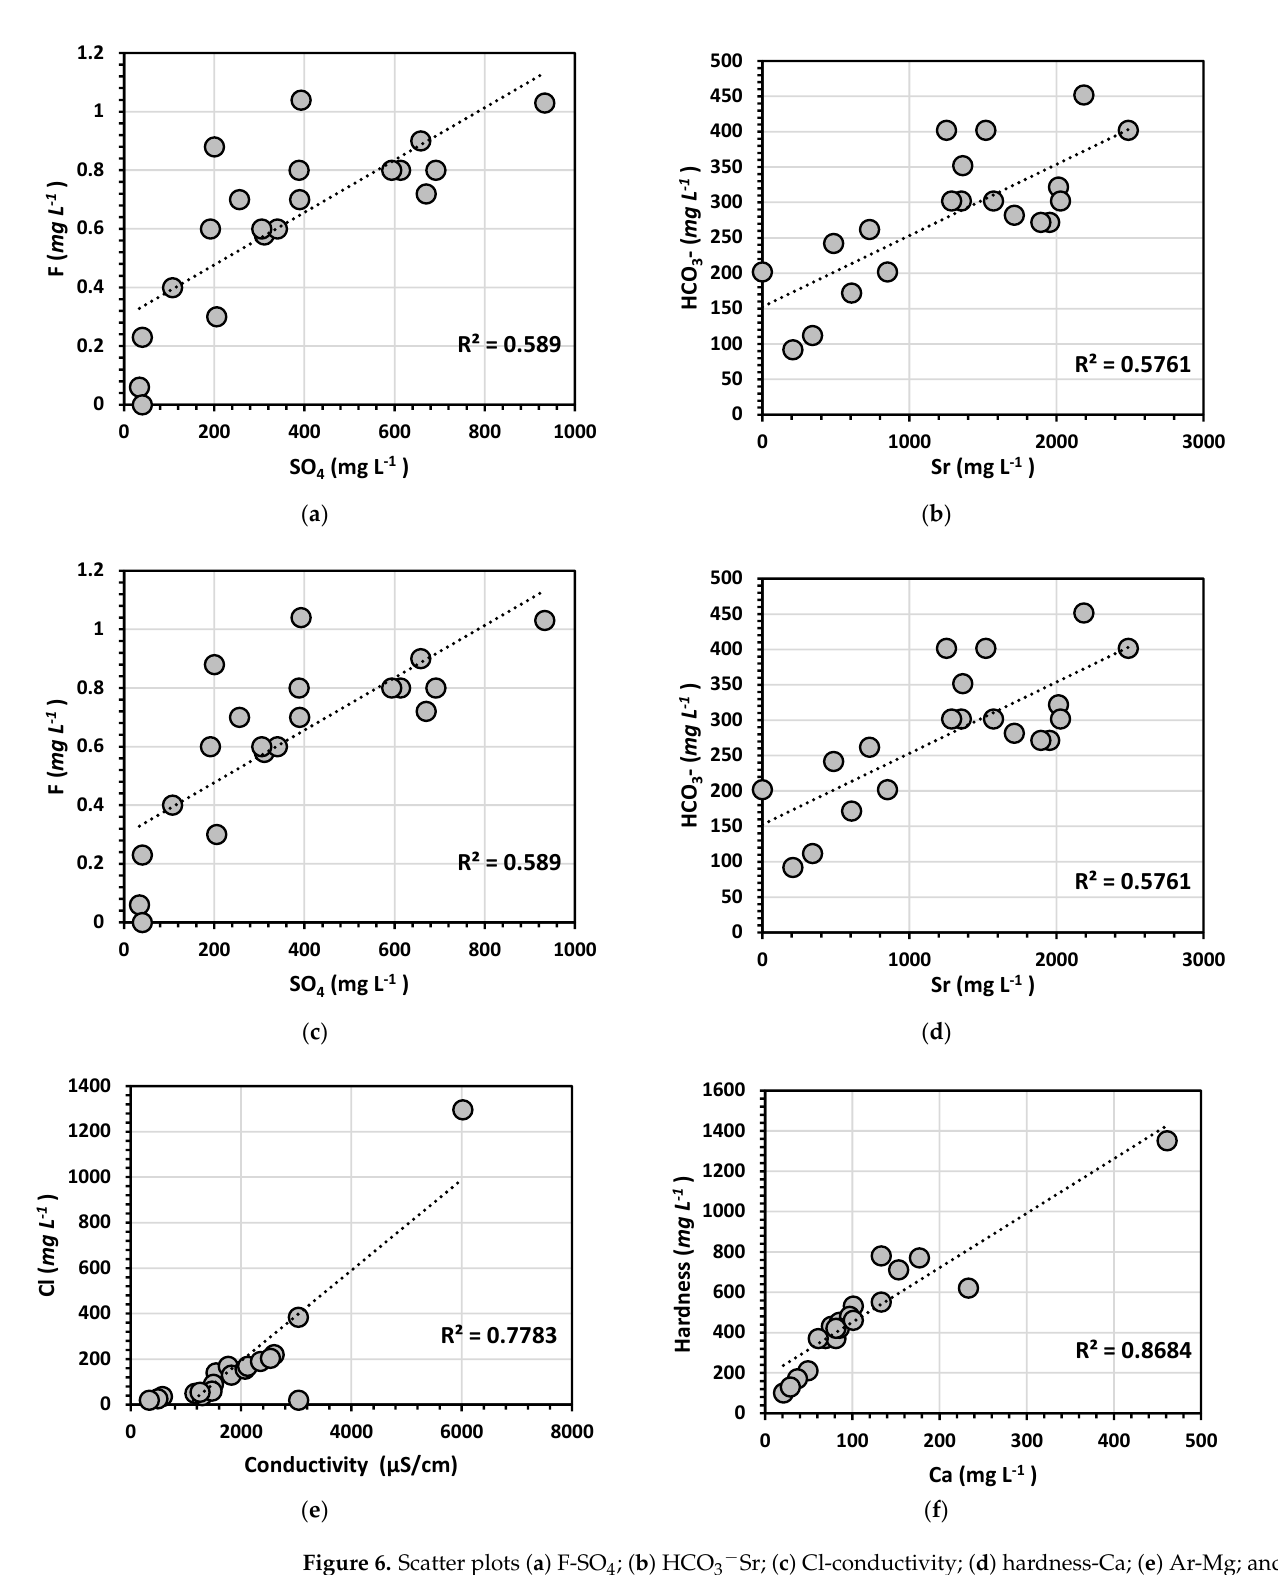
Figure 6. Scatter plots ( a ) F-SO 4 ; ( b ) HCO 3 − Sr; ( c ) Cl-conductivity; ( d ) hardness-Ca; ( e ) Ar-Mg; and ( f ) Ca-Na showing variations in relationships among the measured parameters in water samples taken from the study area.